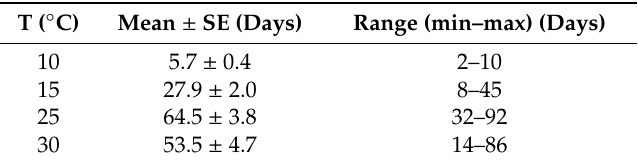
Table 3. Temperate Ae. albopictus adult longevity. Longevity (days) of Ae. albopictus temperate adult females maintained at four constant temperatures: 10, 15, 25, and 30 ◦